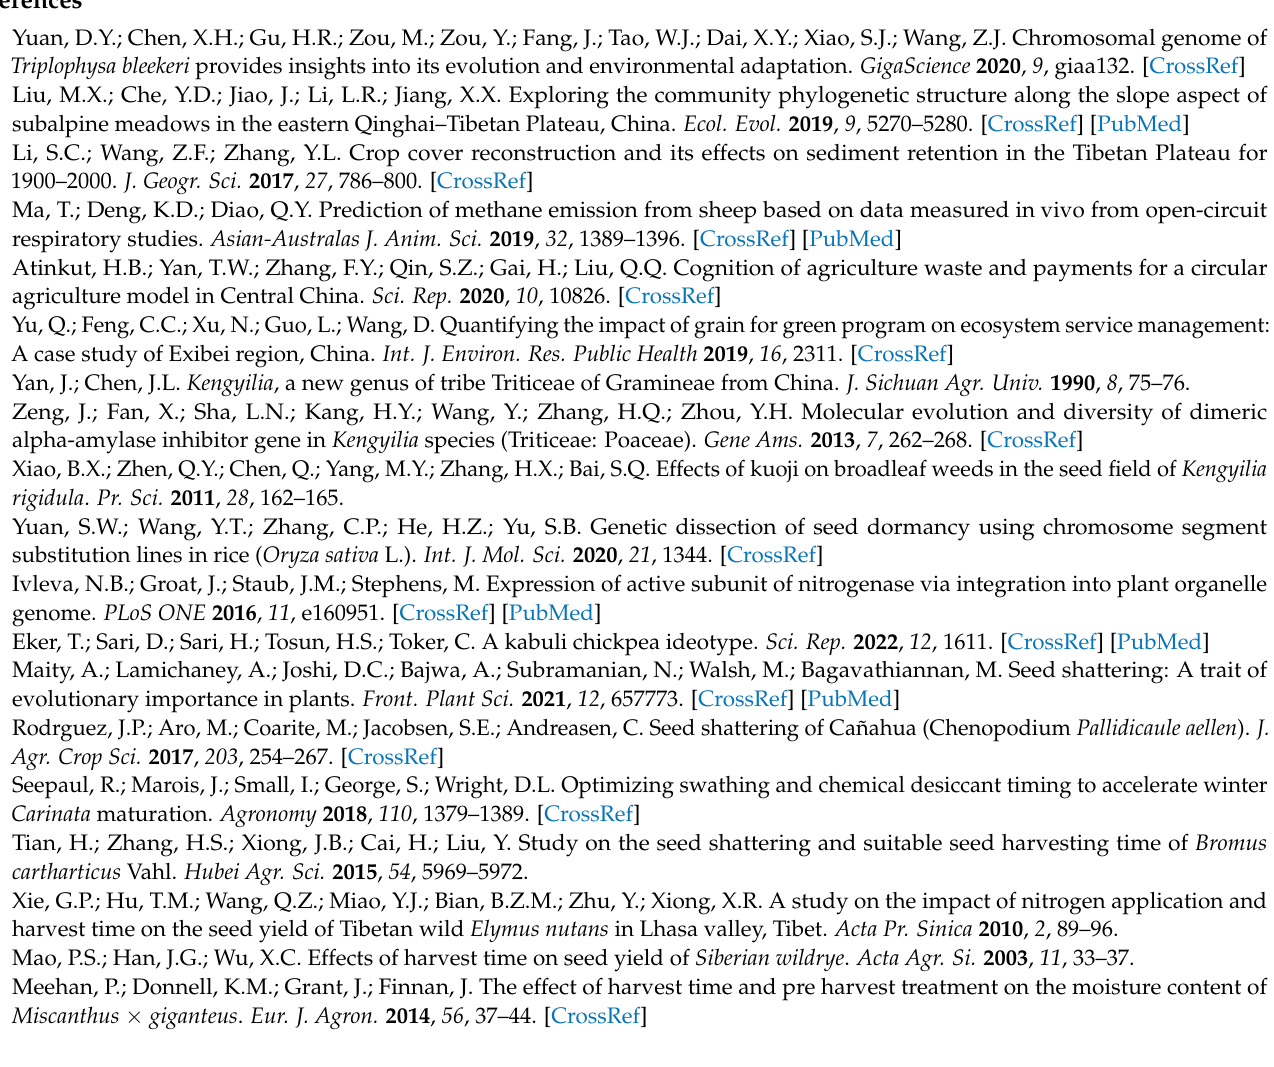
soil. Table S2: The influences of multi-indicator analysis of membership functions on K. melanthera on different days after peak anthesis during the 2017 trial